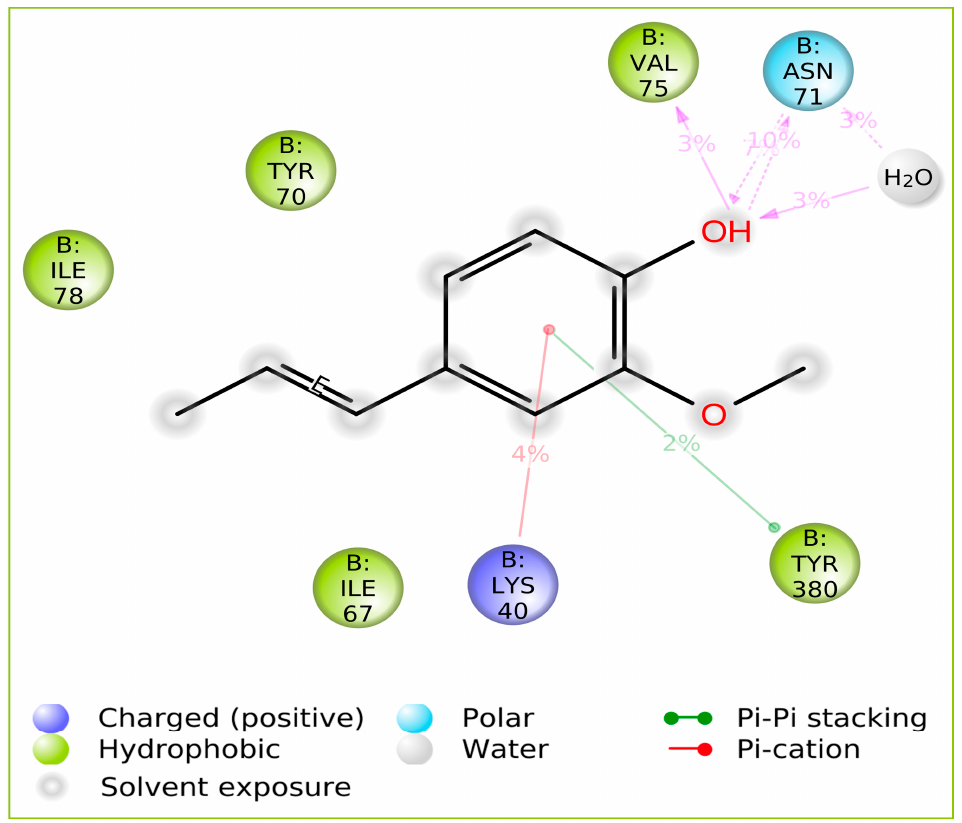
Figure 3. Isoeugenol in complex with penicillin-binding protein 2a of MRSA during MD simulation trajectories of 250 ns.